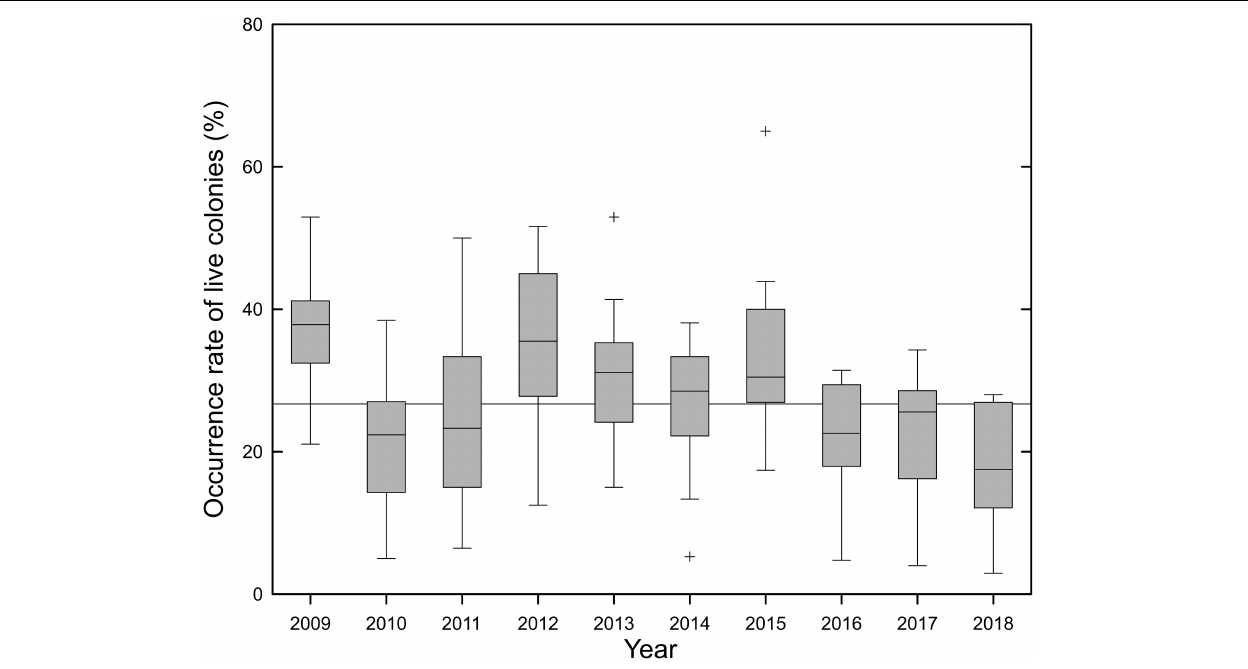
FIGURE 8 | Annual variation in the monthly live colony occurrence rate of precious corals around Taiwan of the Taiwanese precious coral fishery between 2009 and 2018 (box range, first and third quartiles; band, median; whiskers, 1.5 interquartile; cross, outliers. The 26.7% overall average monthly live colony occurrence rate is indicated, gray